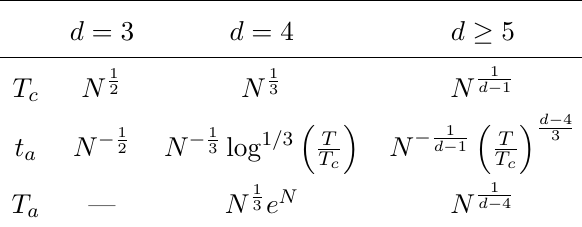
Table 1 . Scaling of the critical temperature T c , crossover time t a and the constraining temperature T a in the vector model for dimensions d (cid:21) 3. The critical temperature follows directly from eq. (2.5), while T a is obtained from the condition t a (cid:24) 1, inserting the asymptotic expressions for (cid:21) m , eq. (2.6) in eq.